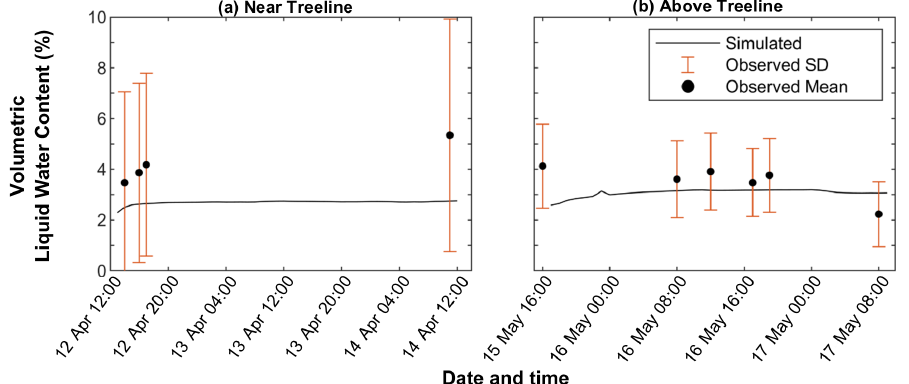
Figure 7. Comparison of SnowTOUGH-simulated volumetric liquid water content ( θ w ) and field observations using ground-based remote sensing for the (a) near-treeline and (b) above-treeline